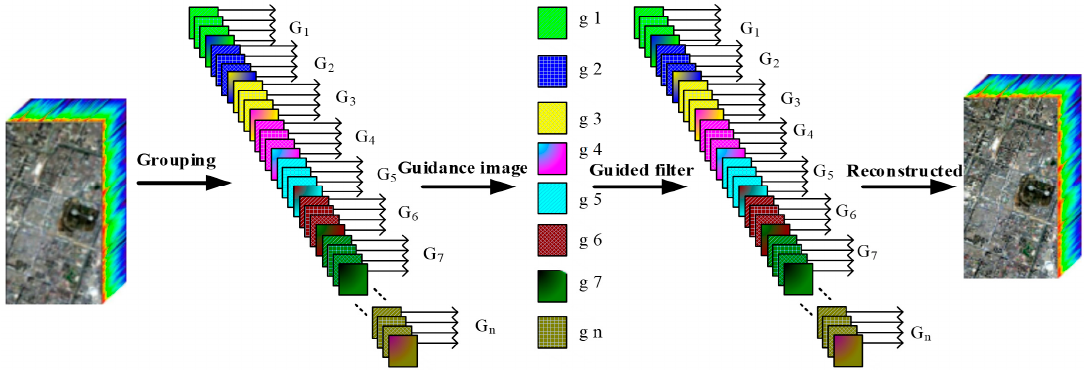
Figure 5. The procedure of band grouping and texture features enhancement.